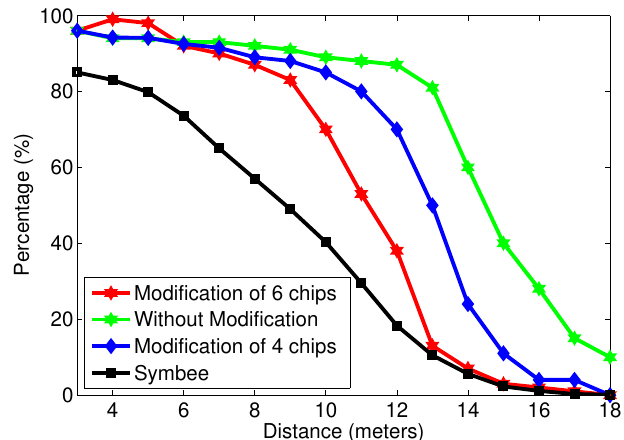
Figure 14. ZigBee packets accepted